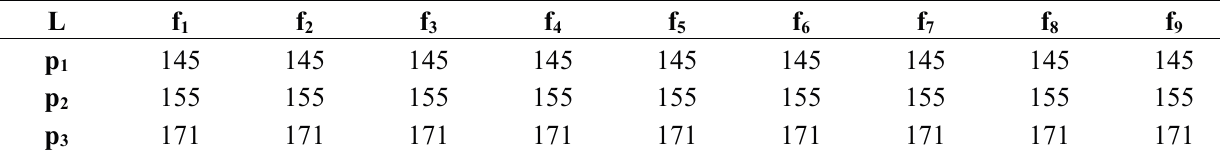
Figure 8. Pre-processed images: ( a ) original; ( b ) segmented; ( c ) masked; ( d ) binarized. Table 4. Image sizes using Row-based Image